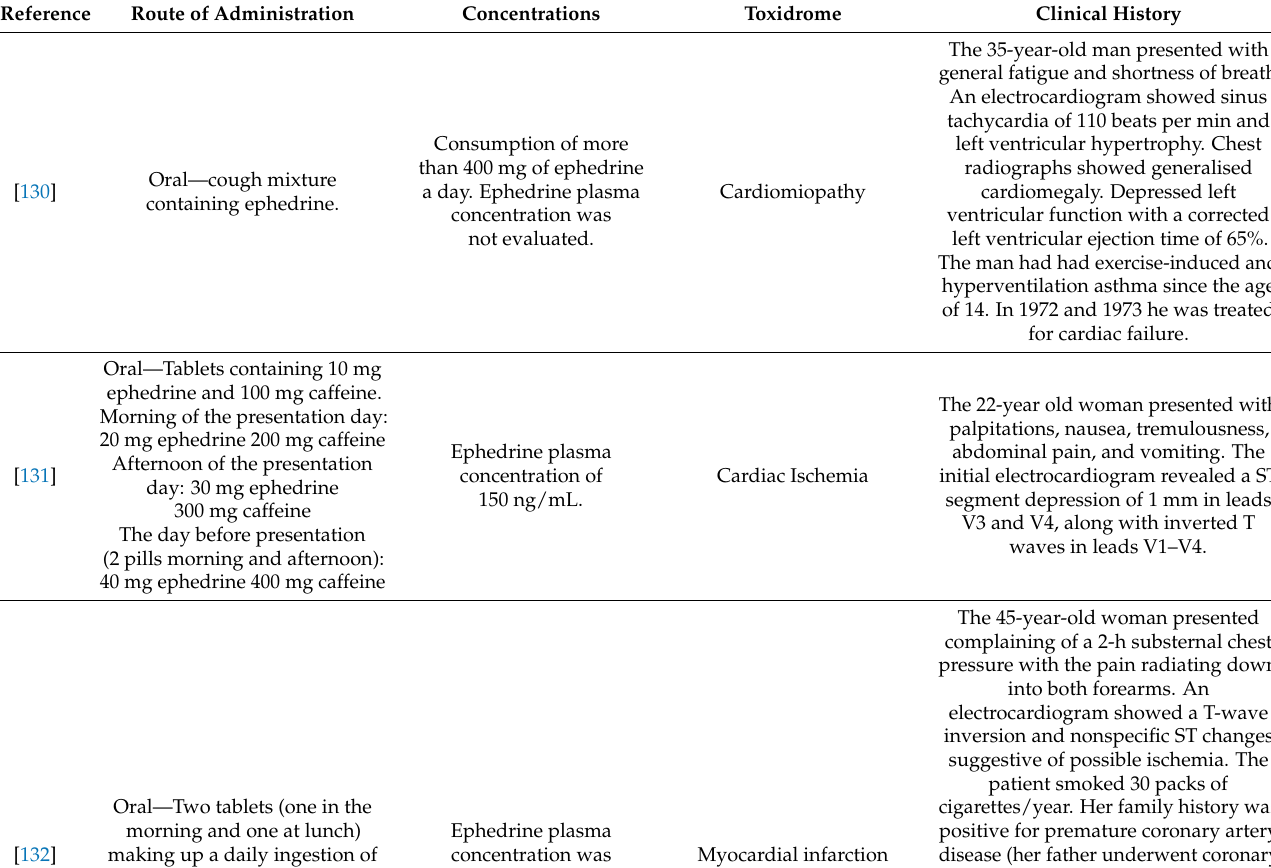
Table 4. Ephedrine related cardiovascular toxicity case reports in